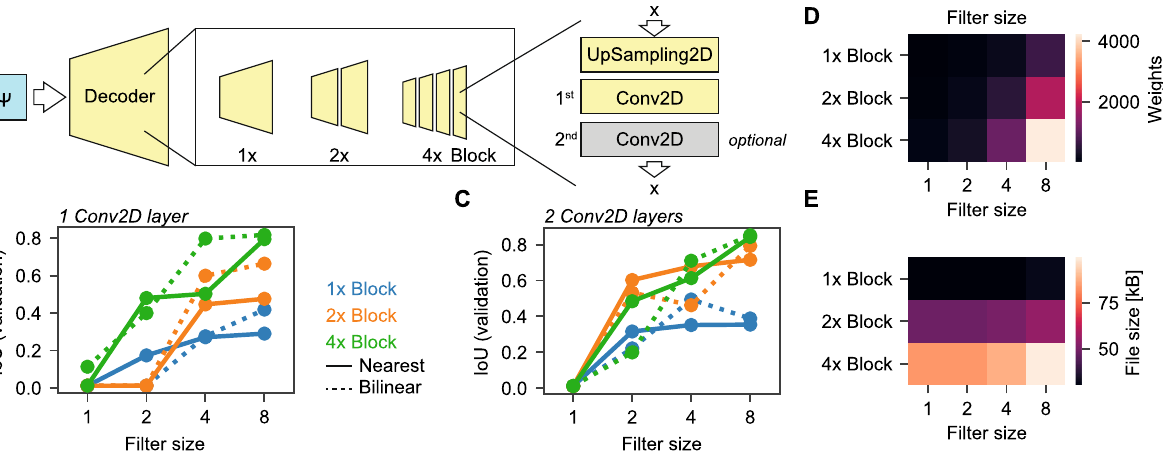
Figure 5. Lean decoders are sufficient for glottis reconstruction from a single latent space image (cid:31) 1 . ( A ) Decoding from latent space image (cid:31) 1 . Evaluated decoders consist of either 1, 2 or 4 upsampling-convolution blocks (right panel), wherein one or two convolutional layers can be present. The filter size of each convolutional layer was fixed (see panels B–E ). ( B ) IoU scores of different decoder blocks (color-coded, 1 blue, 2 orange, 4 green) using either nearest neighbor (solid lines) or bilinear upsampling (dashed lines). ( C ): Same as panel B , but with two convolutional layers. ( D ) Trainable weights across decoder settings for two convolutional layers per block. ( E ) File size across decoder settings for two convolutional layers per